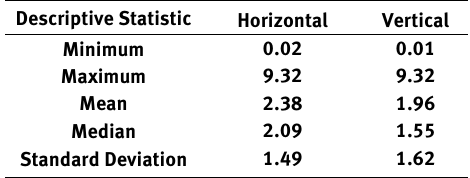
Table 3. Descriptive statistics for HPU and VPU, calculated based on CQ output for 756 marks.